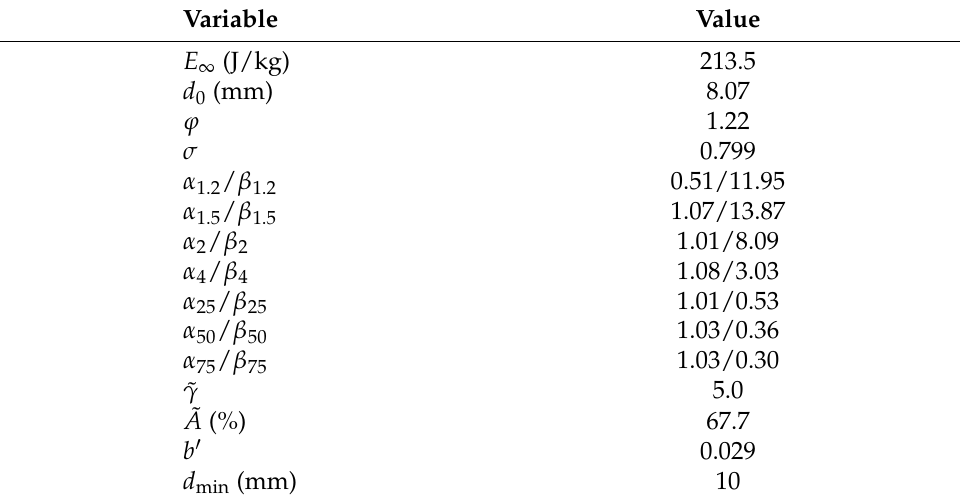
Table 3. Breakage parameters of the copper ore [18].